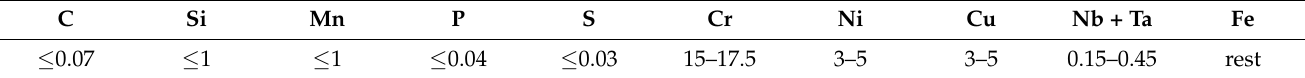
Table 1. AISI 630 composition (wt%) [54].